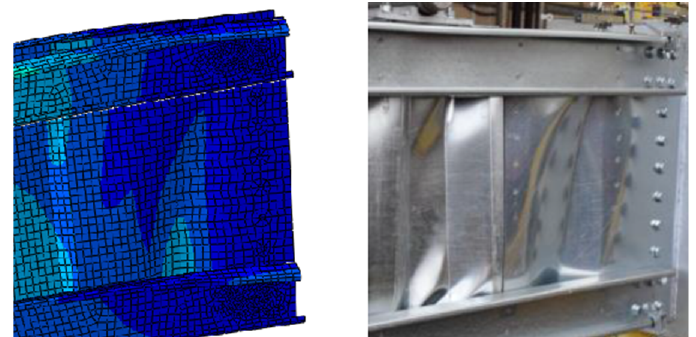
Figure 13. Local buckling of the shear panels in the vicinity of the supports.